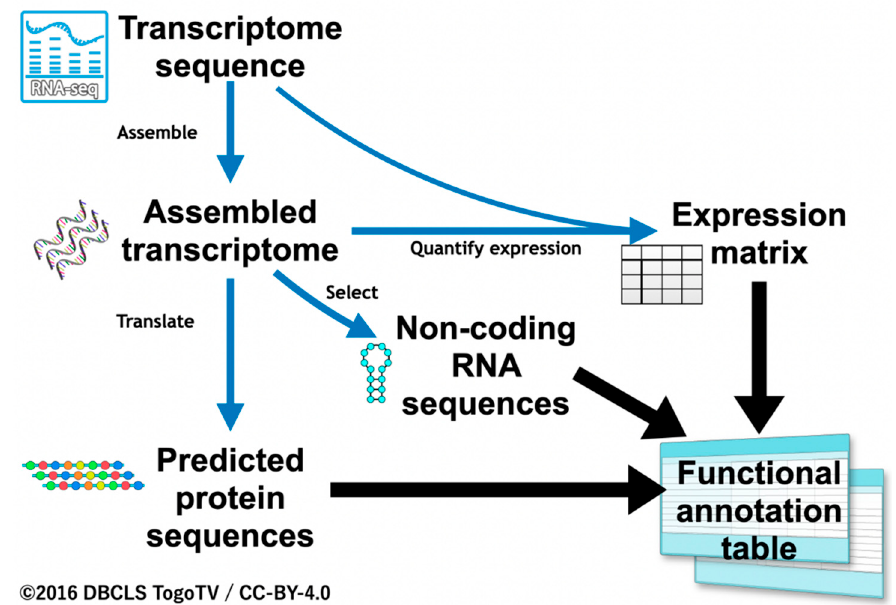
Figure 1. Overview of the annotation workflow, Fanflow4Insects.